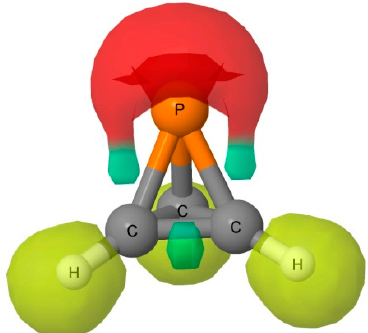
Figure 3. ELF 0.8 isosurface. Yellow, red and green indicate the hydrogenoid, monosynaptic, and disynaptic basins, respectively.